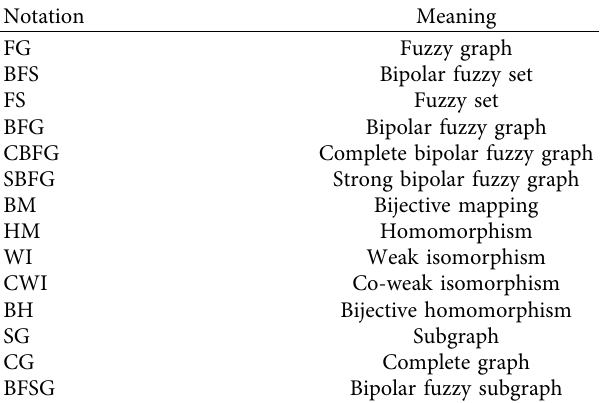
Table 1: Some basic